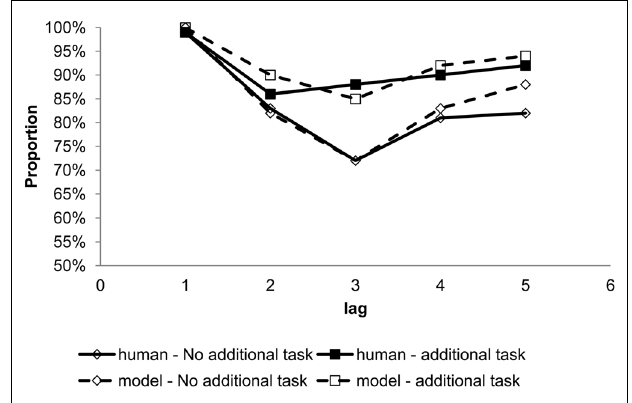
FIGURE 10 |Target report accuracy by serial position comparing human data (Olivers and Nieuwenhuis, 2006) and model simulation for with and without distraction, i.e., an additional